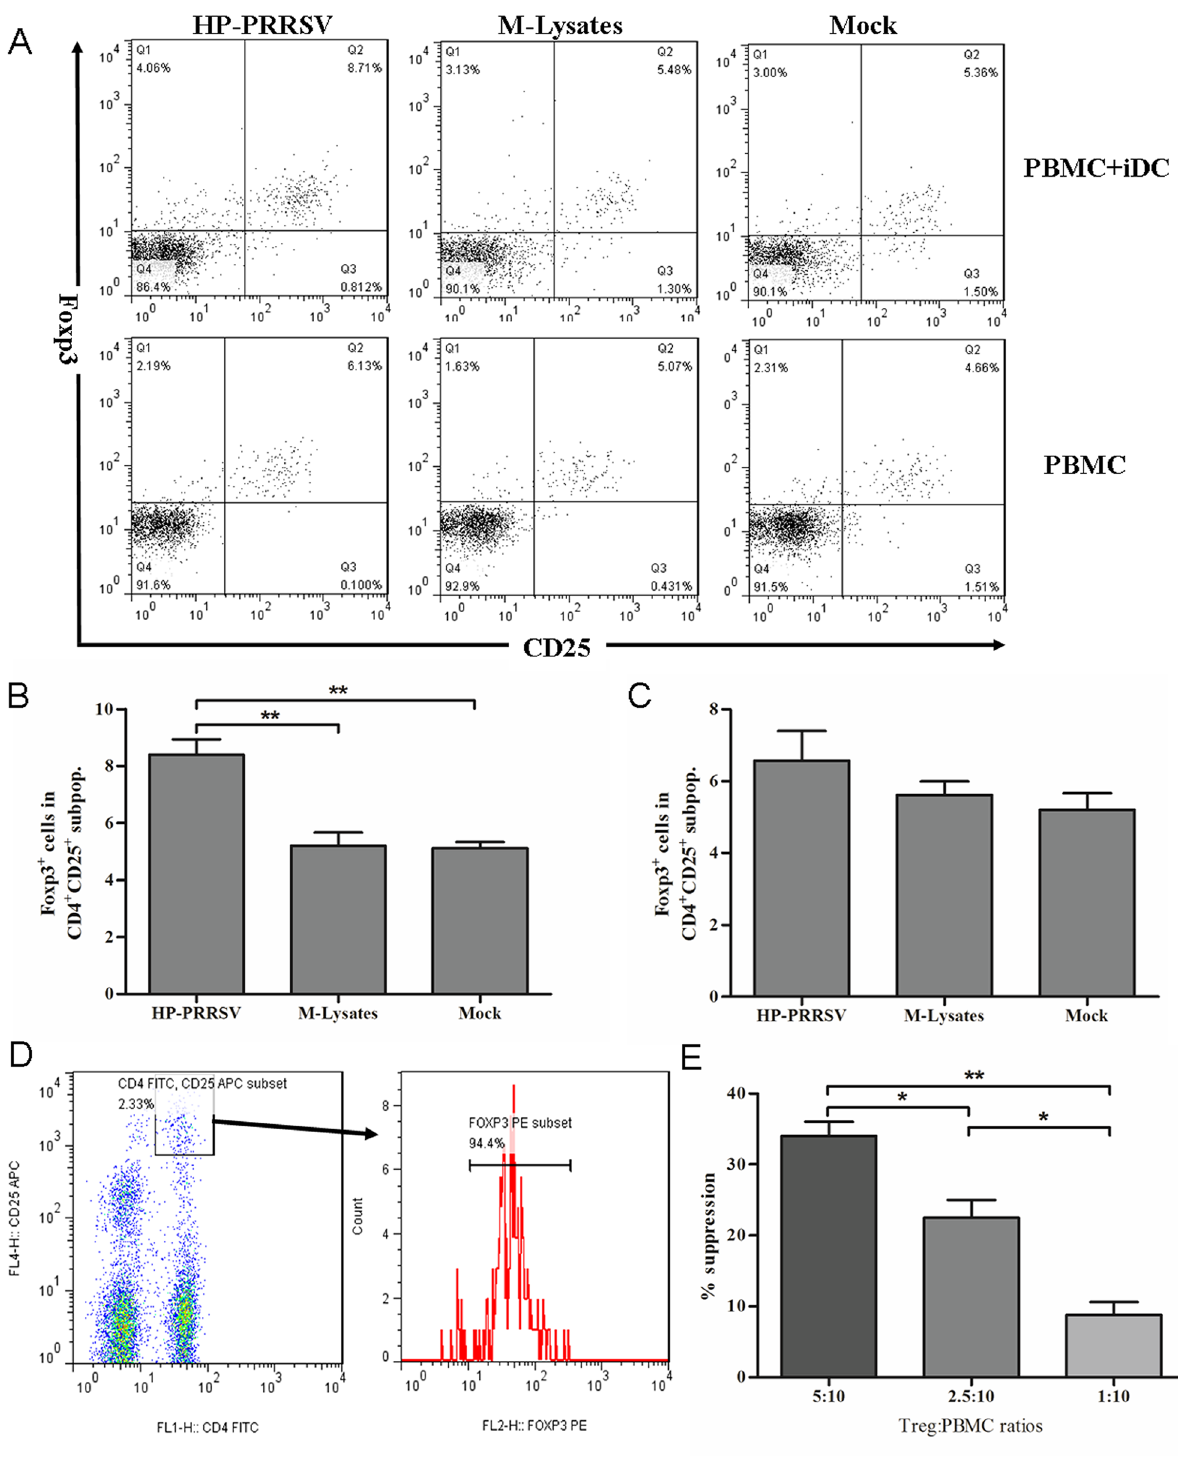
Fig 1. Induction of Tregs from lymphocytes co-cultured with PRRSV-infected MoDCs. (A) Representative flow cytometry profile of lymphocytes following 3 days co-culture of PBMCs with PRRSV-infected MoDCs (upper layer), and only culture with PRRSV-infected PBMCs (lower layer). (B) Percentage of Foxp3 + cells in the gated CD4 + CD25 + subpopulations of PBMCs co-cultured with PRRSV-infected MoDC. (C) Percentage of Foxp3 + cells in the gated CD4 + CD25 + subpopulations of PRRSV-infected PBMCs alone. (D) Sorted CD4 + CD25 high cells. (E) Percentage suppression at the indicated Tregs: peripheral lymphocyte ratios. The lymphocytes exposed to Marc-145 lysate-treated MoDCs were used as negative control. The percentage of